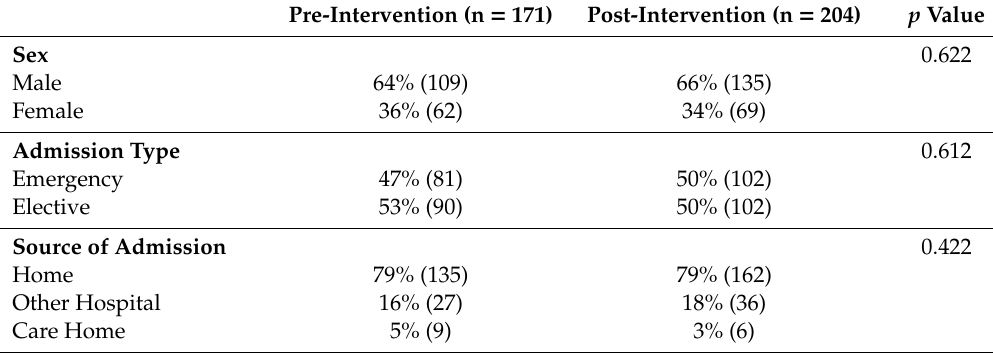
Table 1. Demographics of adults aged 65 years and older admitted under vascular surgery in the pre- and post-intervention study groups. Numbers are percentages with raw values in parentheses unless otherwise stated